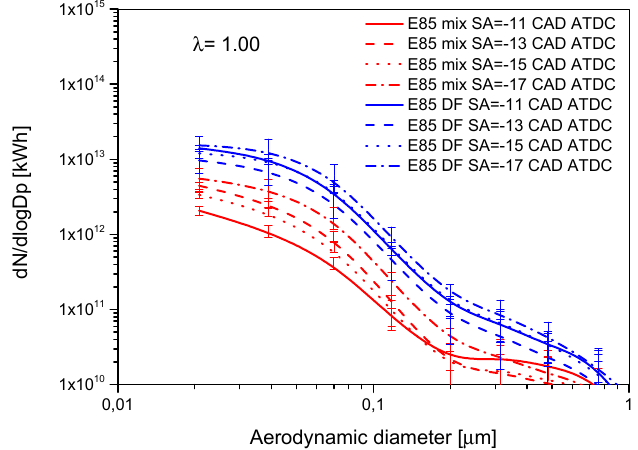
Figure 15. Particle size distribution for λ = 1.